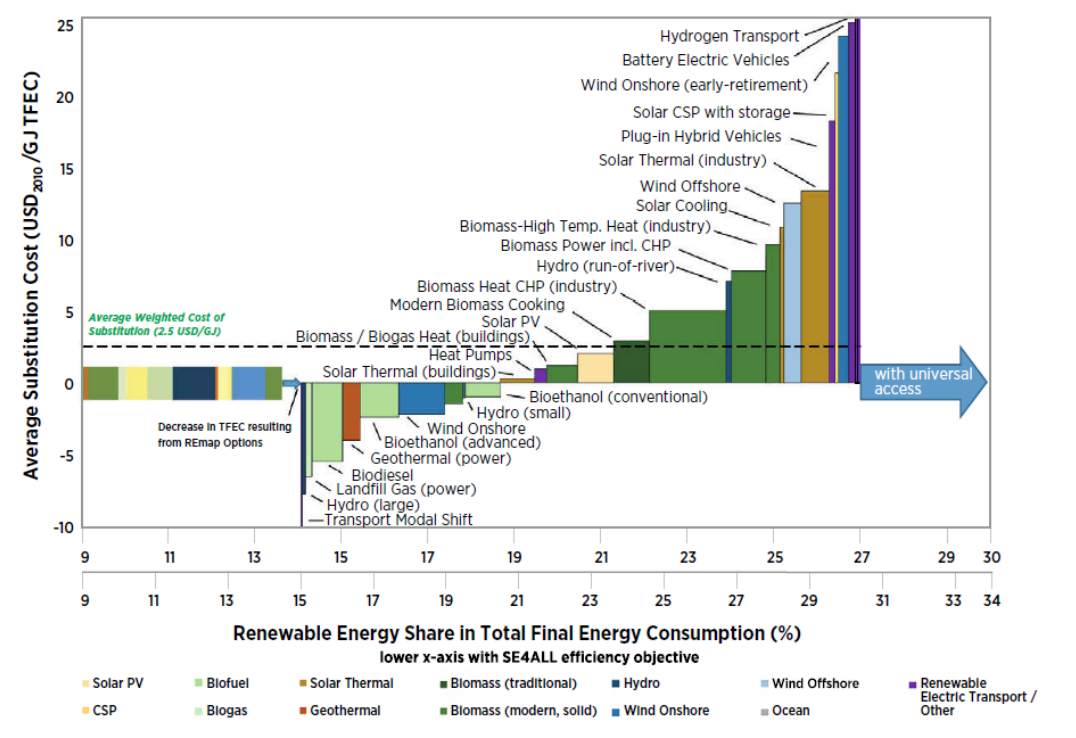
Figure 4. Global cost-supply curve of REmap Options in year 2030. Source: